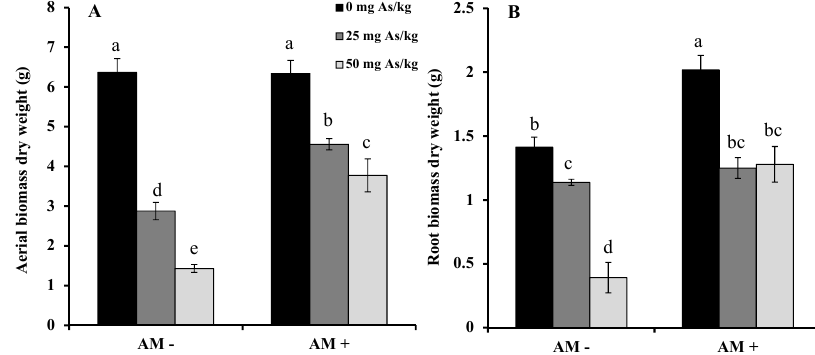
Figure 1. ( A ) Soybean aerial biomass (dry matter); ( B ) soybean root biomass (dry matter). Letters indicate significant differences between treatments ( p < 0.05), as assessed by Tukey’s